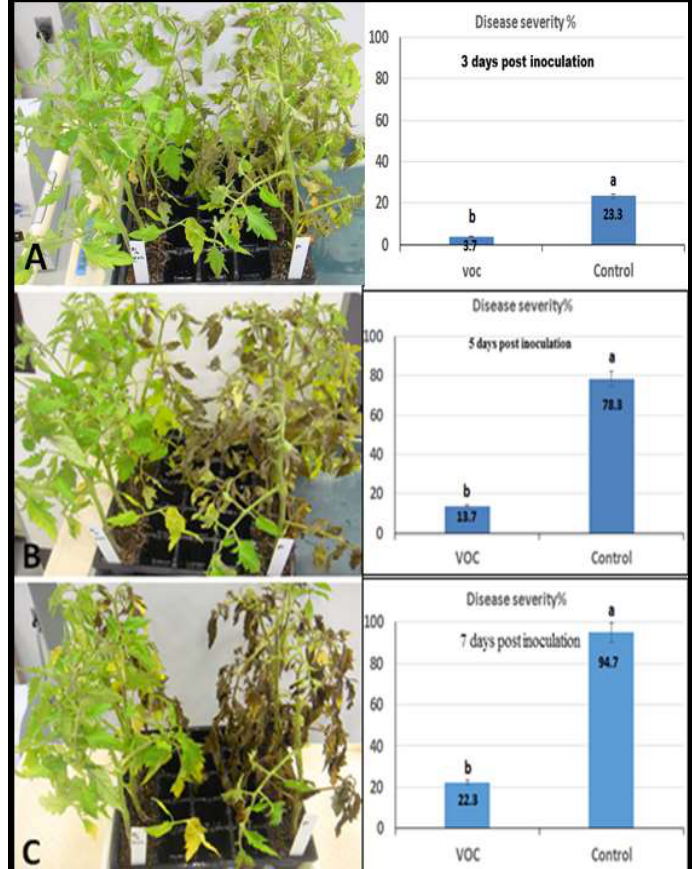
Figure 7. Efficacy of VOCs on tomato late blight through a whole-plant approach where the left row refers to sprayed plants by P. infestans and VOCs whereas the right row refers to infected plants (positive control). ( A ) Symptoms three days post-inoculation, ( B ) symptoms five days post- inoculation, ( C ) symptoms seven days post-inoculation. Values in the same bar chart with different letters are significantly different at p <